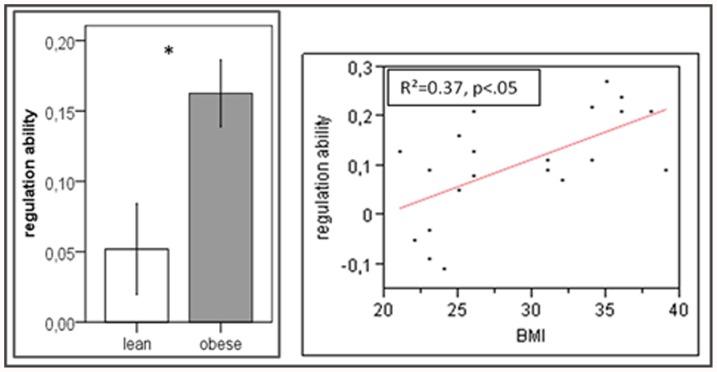
Regulation ability.Left: Bar graph of differences in the regulation ability between lean and obese participants. The bar-plots represent mean regulation ability ± SEM. Right: Scatterplot and regression line of the regulation ability and BMI.